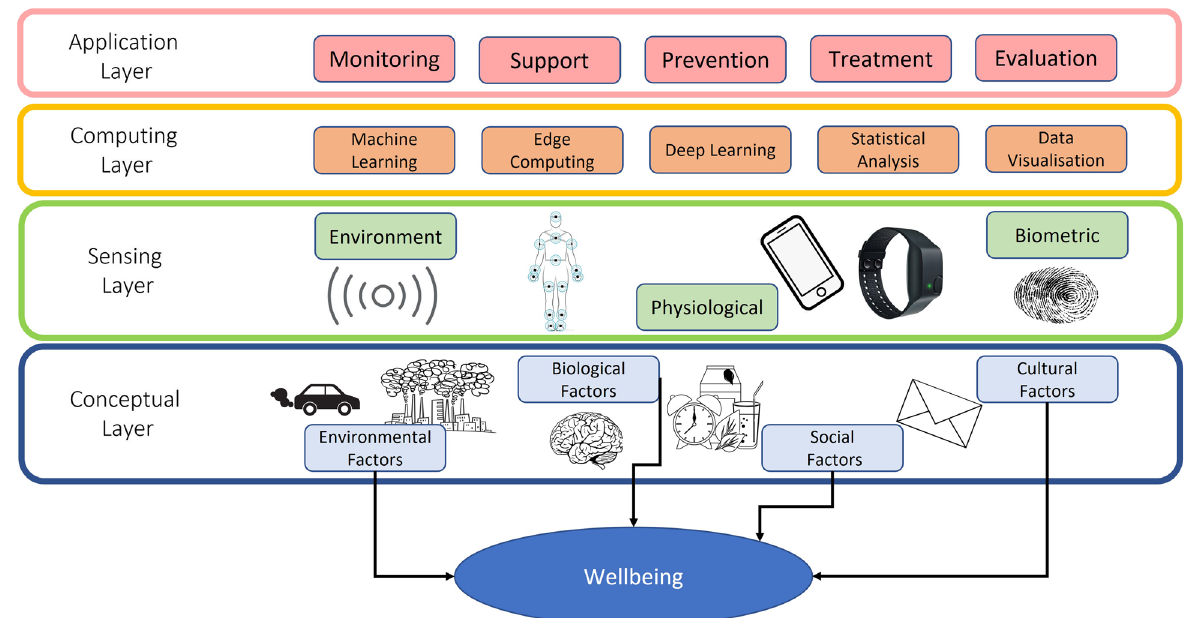
Fig. 3 The conceptual and system architecture of DigitalExposome for calculating the impact to mental